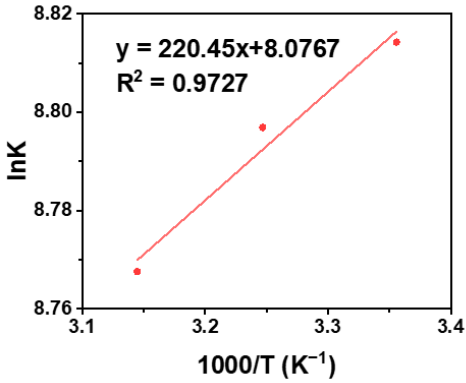
Figure 5. Fluorescence quenching curve of AA-BSA system.